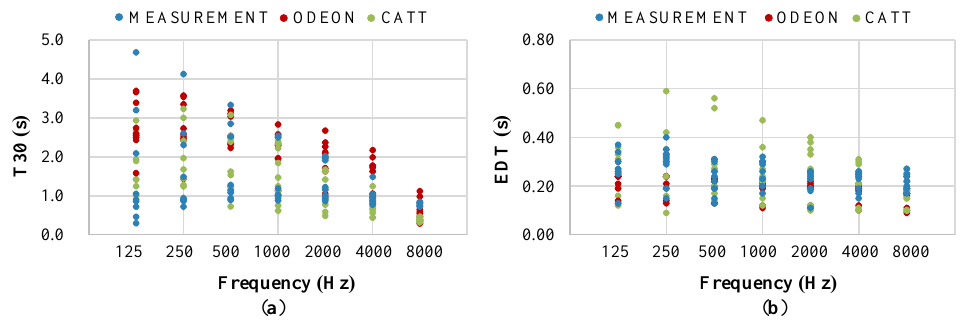
Figure 10. ( a ) Dispersion of T30 in measurement at point 1. ( b ) Dispersion of T30 in measurement at point 1.